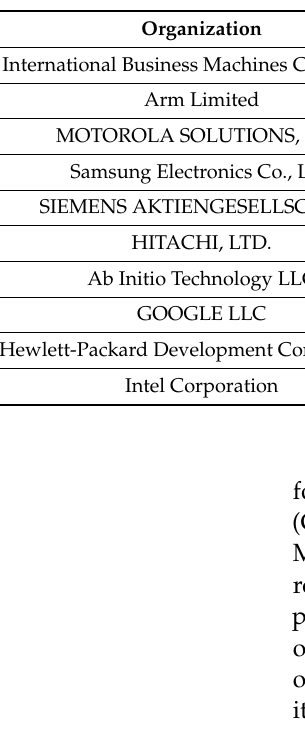
Table 6. Top organizations by granted